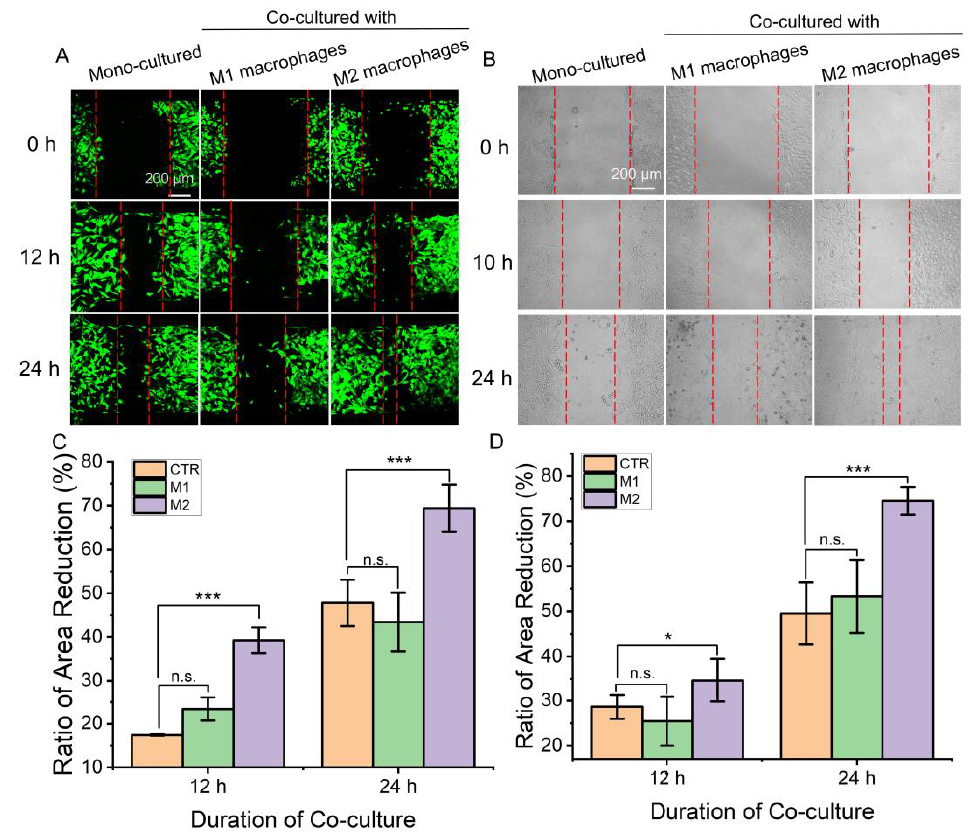
Figure 4. The migration ability of fibroblasts under co-culture with different macrophages. ( A , C ) A picture for representative regions showing fibroblast migrated at the septum formed when the air valve closed and a comparison of the area reduction. Measure the reduction of inter-fibroblast septal area relative to 0 h. ( B , D ) Images of fibroblast migration at scratches in a conventional transwell co-culture system and comparison of the area reduction. Measure the reduction of scratch area relative to 0 h. Herein, “CTR” refers to mono - cultured, “M1” and “M2” refer to “co -cultured with M1 macrophages” and “co - cultured with M2 macrophages”. Data are presented as mean ± SD (n = 3). “*” is the intragroup comparison with “CTR”. * p < 0.05; *** p < 0.001.